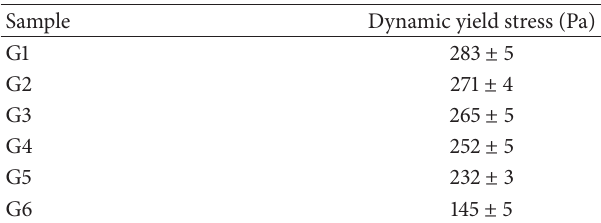
Figure 4: Complex shear modulus ( 𝐺 ∗ ) versus angular frequency dependence of the hydrogels.